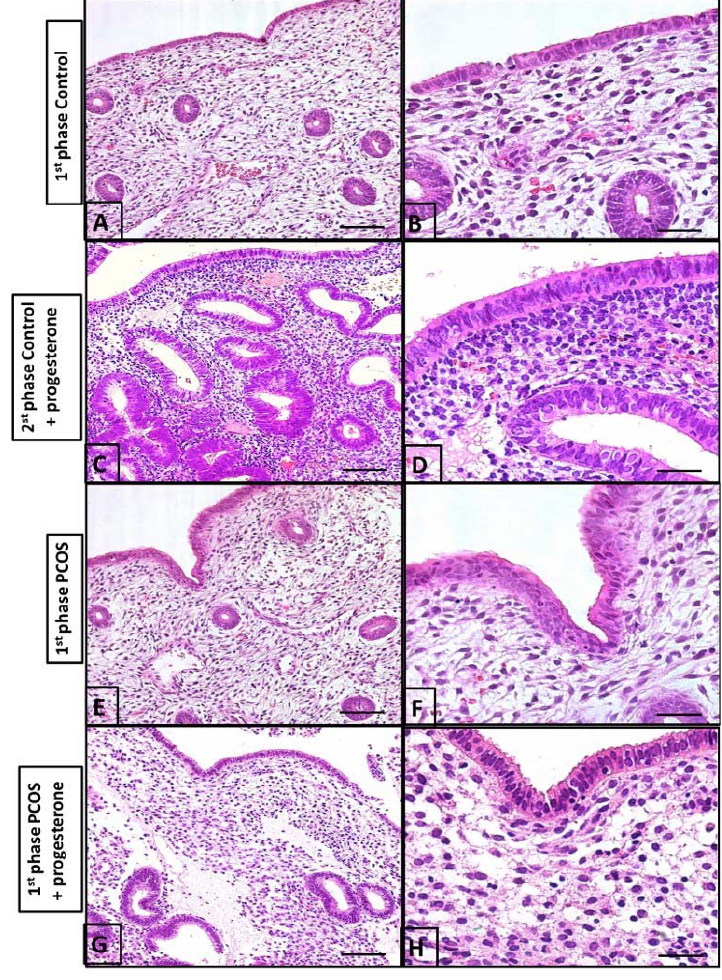
Figure 4. Histological evaluation of the endometrium. ( A ) the surface shows simple columnar epithelium and the endometrial coiled glands during the first phase of the menstrual cycle; ( B ) the lamina propria is rich in blood vessels and intercellular substances during the first phase of the menstrual cycle; ( C ) the second phase of the menstrual cycle upon undergoing progesterone treatment showing numerous endometrial glands compared to those in ( A ) (1st phase of cycle), with a high number of cells in the stroma; ( D ) the second phase of the menstrual cycle upon undergoing progesterone treatment columnar epithelium; ( E ) the endometrium of a PCOS patient. Note the cell-rich lamina propria is slightly more developed than in ( A , B ); ( F ) the endometrial gland and vessels are similar to ( A , B ); ( G ) leukocytes in the stroma are numerous, with lesser endometrial glands than in the control group ( C , D ); ( H ) few endometrial glands and pseudo-stratified epithelium. These findings are different from ( C , D ). Bars in ( A , C , E , G ) and in ( B , D , F , H ), are 40 µ m and 5 µ m, respectively.